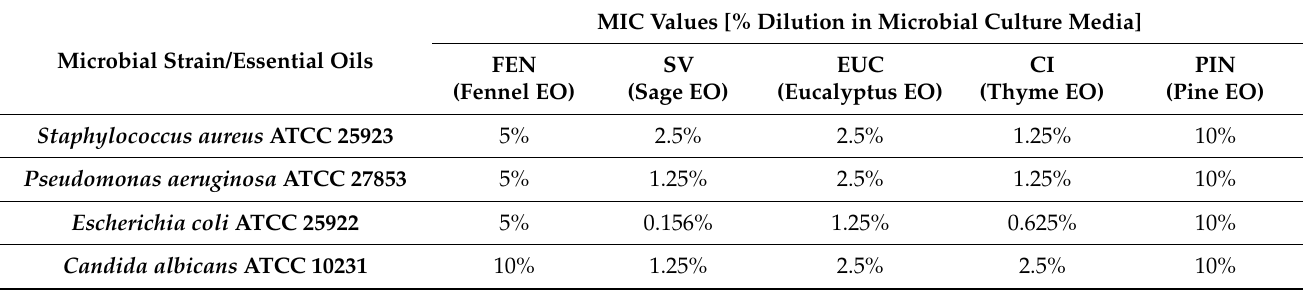
Table 6. MIC values were obtained by the method of serial micro dilutions in a liquid